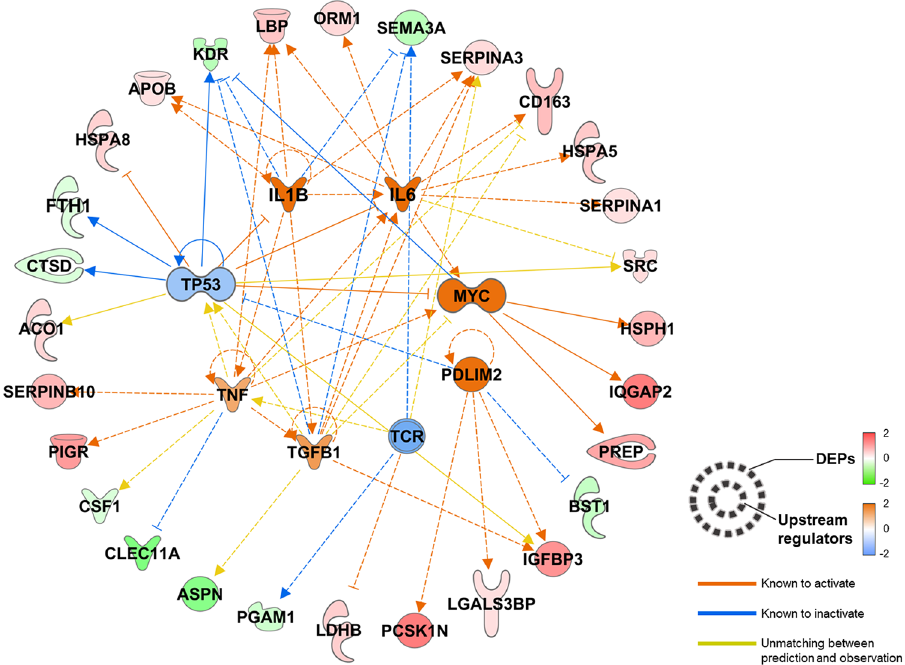
Figure 5. Upstream regulator–downstream plasma DEP network. The upstream regulators that were known or reported to regulate the input DEPs at the upper level were searched, and their status was calculated using